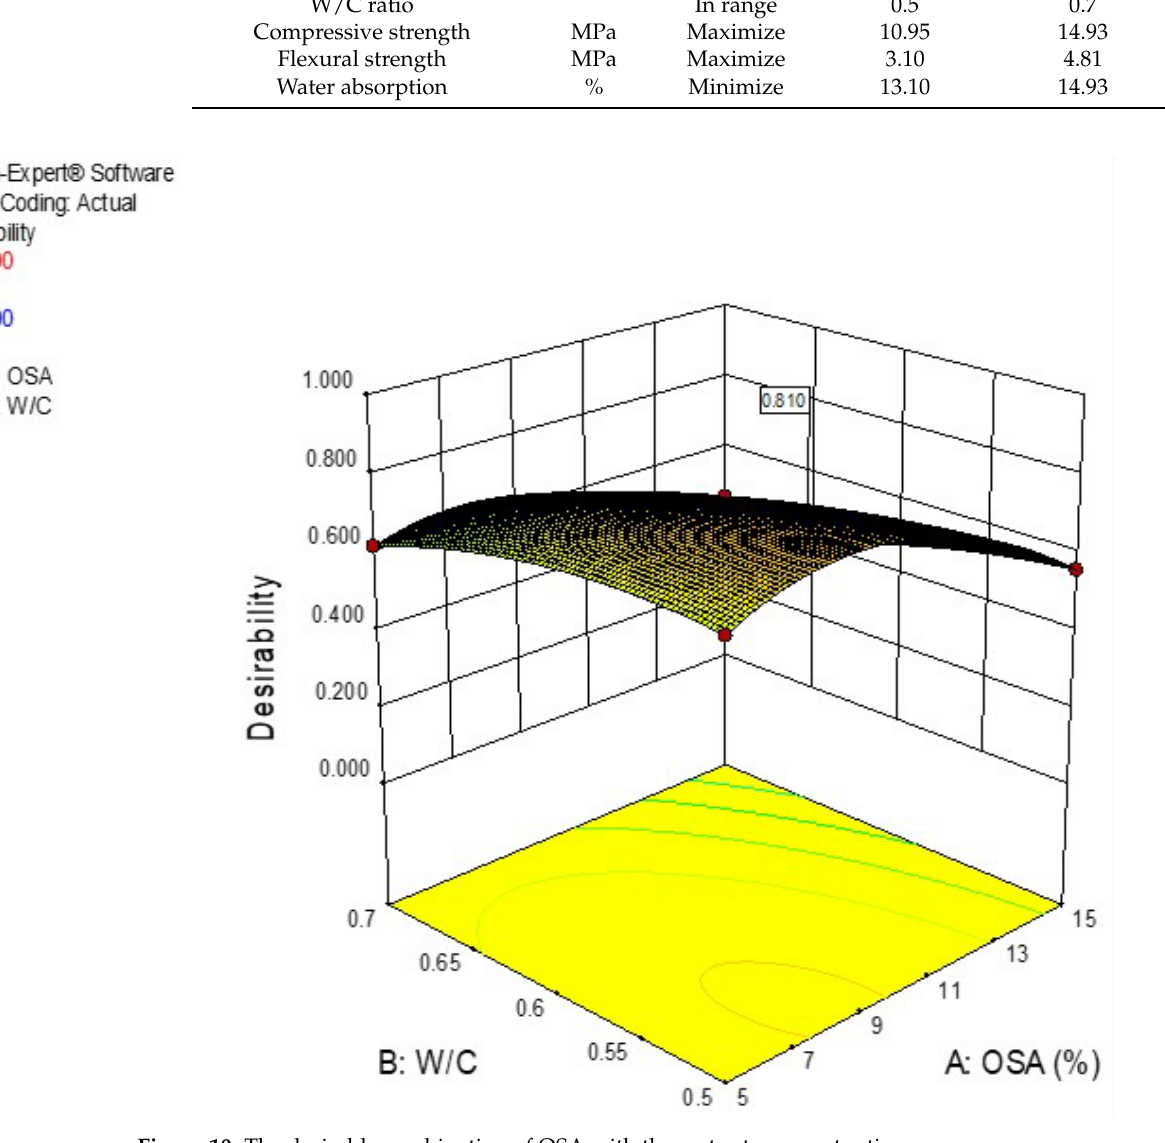
Figure 10. The desirable combination of OSA with the water-to-cement ratio.